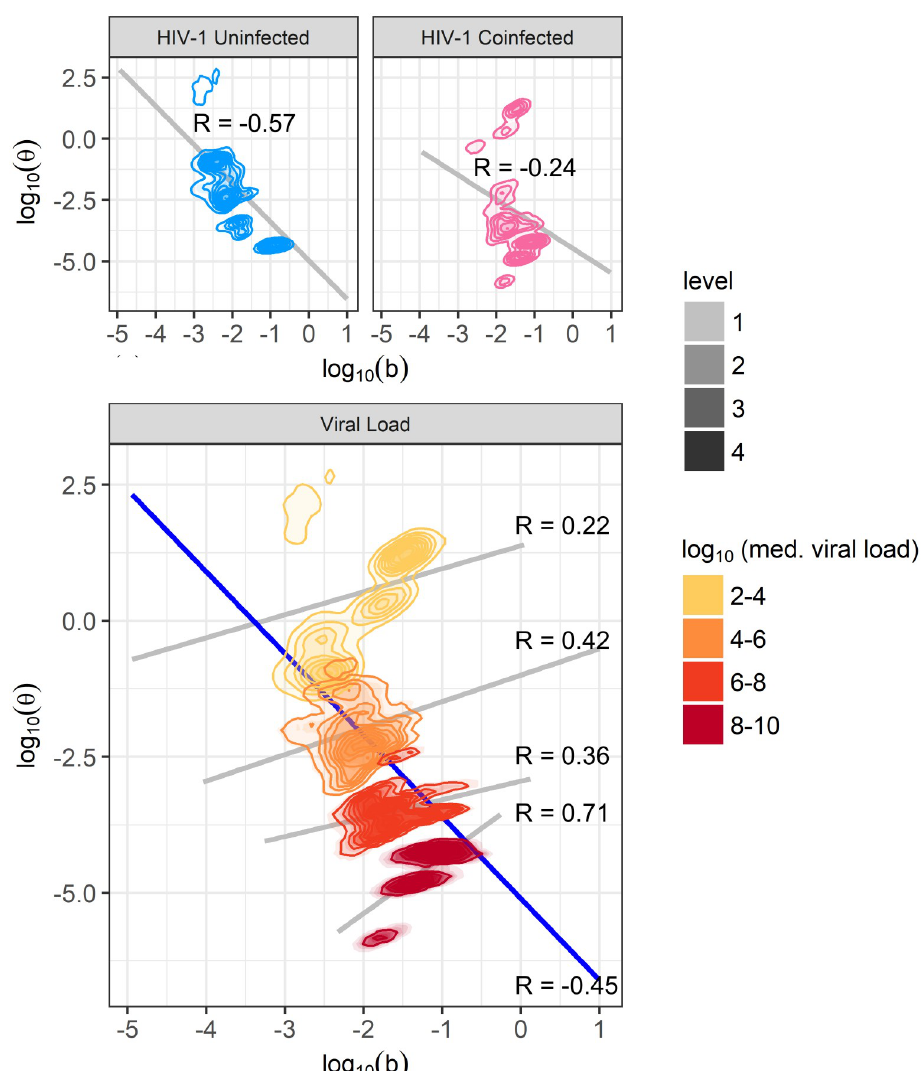
Fig 6. Correlation between parameters b and θ . Obtained densities of parameters b and θ are plotted, stratified by HIV-1 infection status and median oral EBV viral load group. Across all participants, or when stratifying by HIV-1 infection status, b and θ are negatively correlated (grey lines in top plots and blue line in bottom plot). However, since b and θ have opposite effects on viral load, positive correlations are seen within each viral load group (grey lines, lower